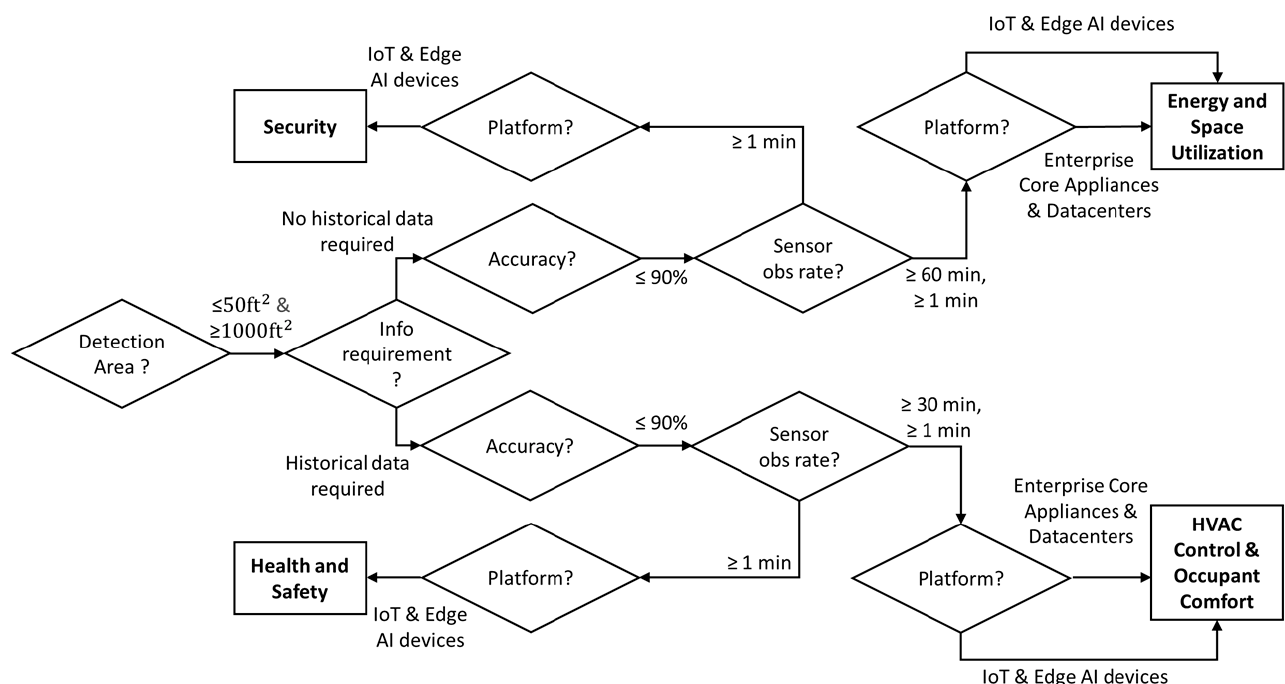
Figure 1. A decision tree that illustrates the expected use of ADPs (in diamond shaped boxes) to determine the suitable application area for the reviewed method. The same illustration is used to perform suitability analysis in Section 6. Sensor failure rate ADP is not used in the decision-making process as some reviewed methods did not specify the sensor details.